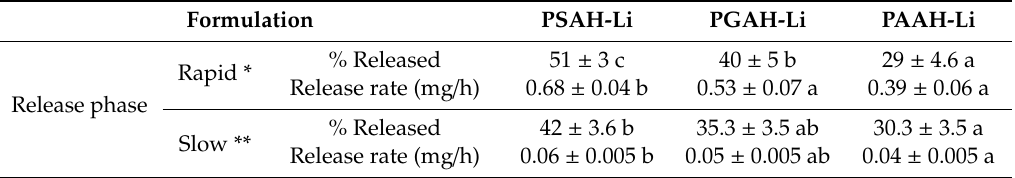
Figure 6. Release profile of linezolid from prepared hydrogels in phosphate buffer saline (PBS) at 33.4 °C; mean Scanning Electron Microscopy (SEM) ( n = 3). Different letters next to the standard deviation on each point indicate statistically significant differences using Tukey HSD, at 95% confidence. Table 5. Release profile of linezolid-loaded